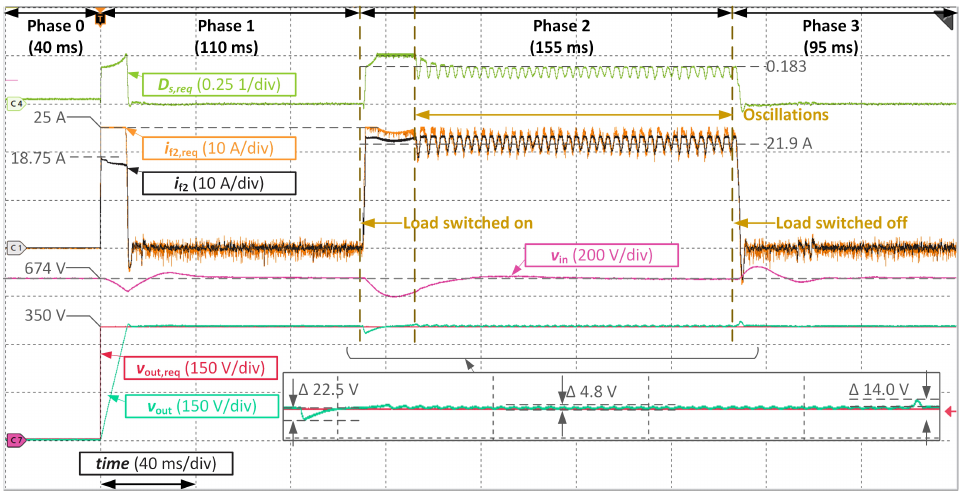
Figure 18. Experimental results for controllers tuned according to parameters (Equations (31)–(33)) and Equations (48) and (49): reference voltage value for the active rectifier v in,ref = 670 V, reference output voltage value for the DAB converter v out,ref = 350 V, additional current limitation I spec = 25 A, resistive load R = 16 Ω